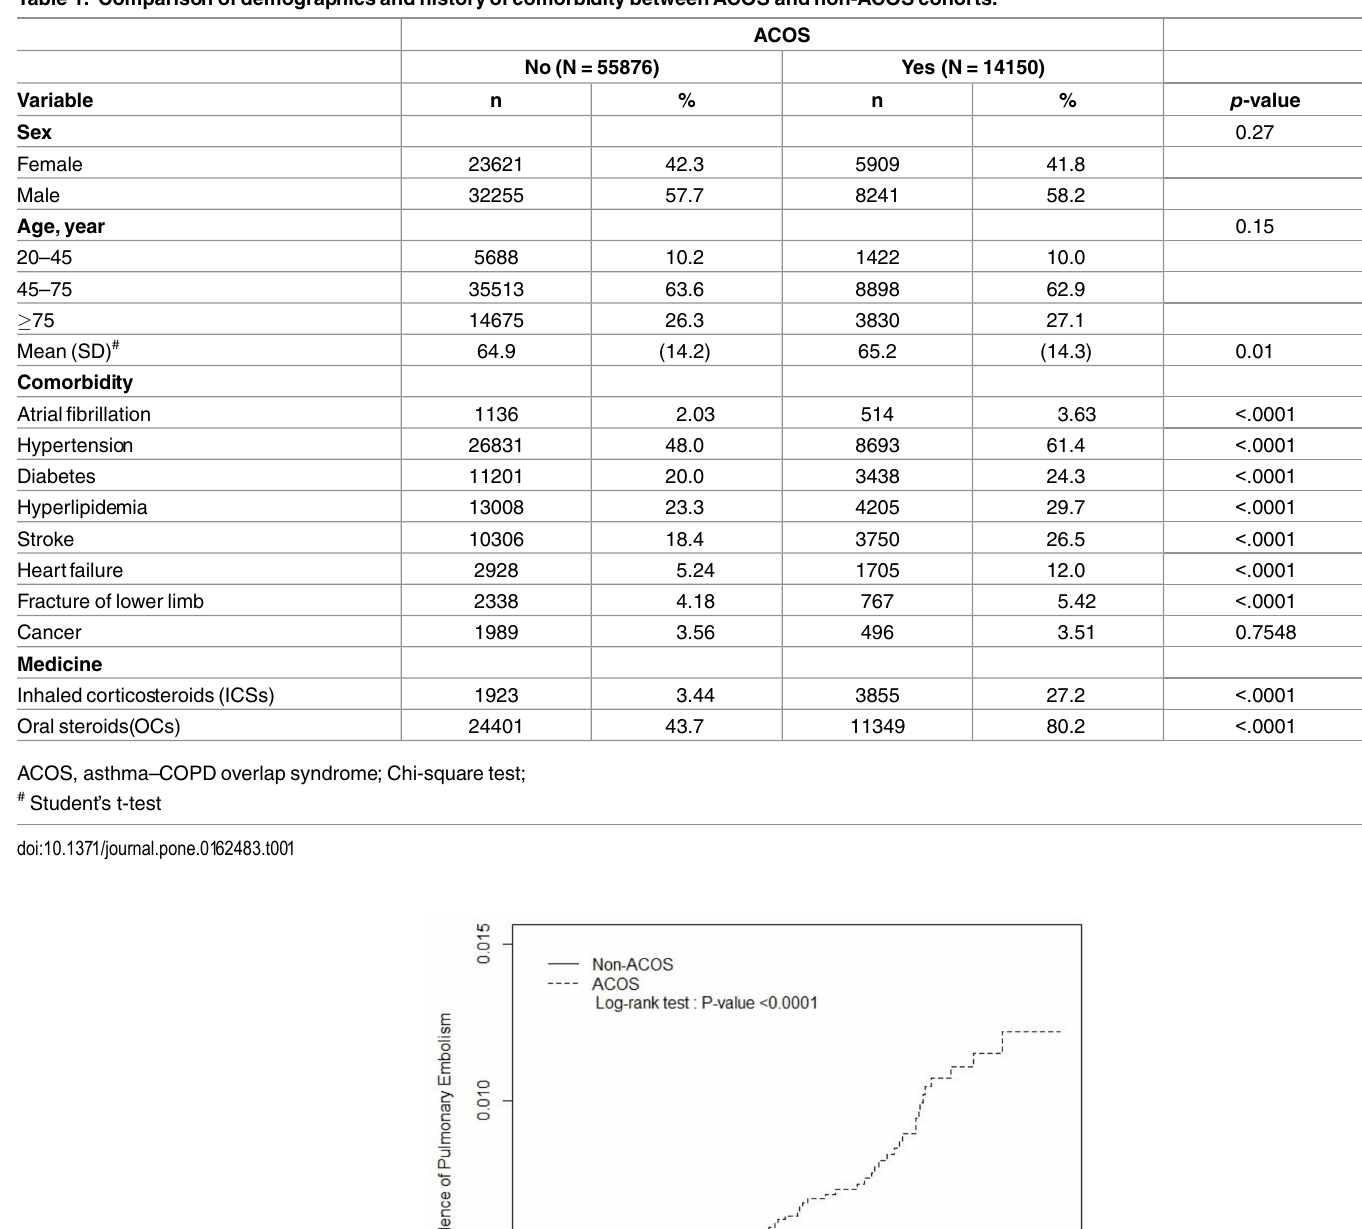
Table 1. Comparison of demographics and historyof comorbiditybetweenACOS and non-ACOS cohorts.